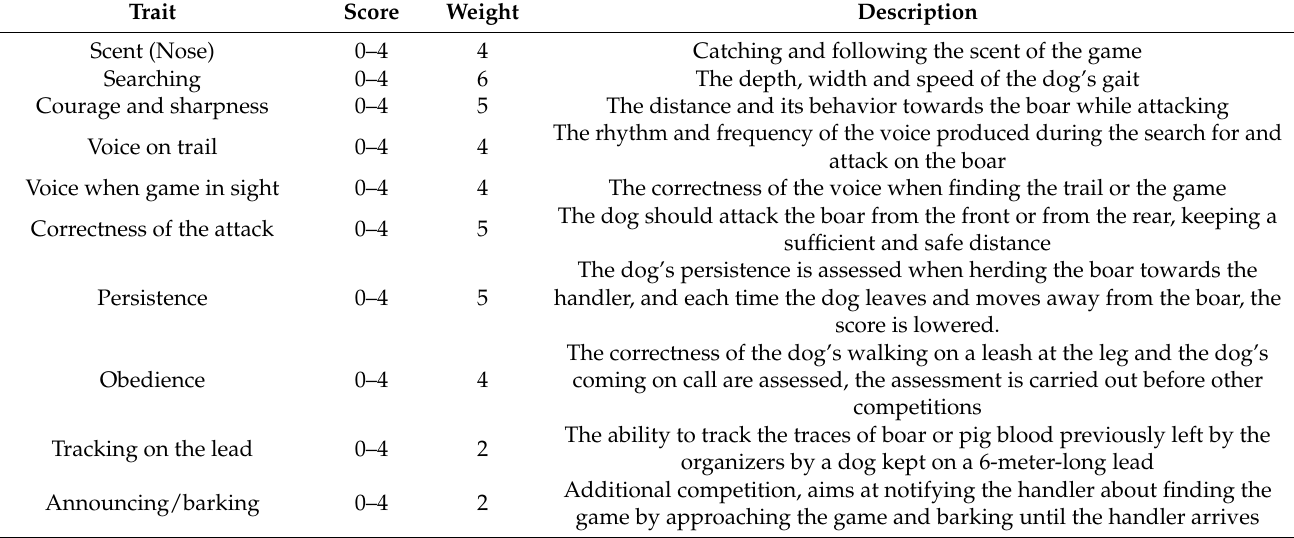
Table 1. Description of traits and scoring system included in hunt trial for